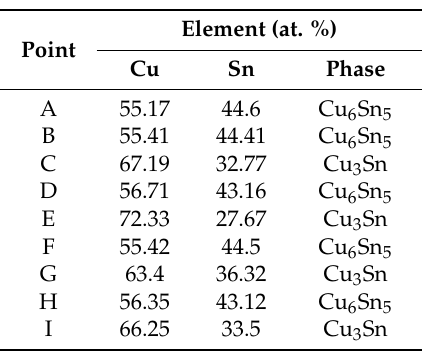
Table 4. The element atomic percentage by energy dispersive X-ray (EDX) analysis for Figures 11 and